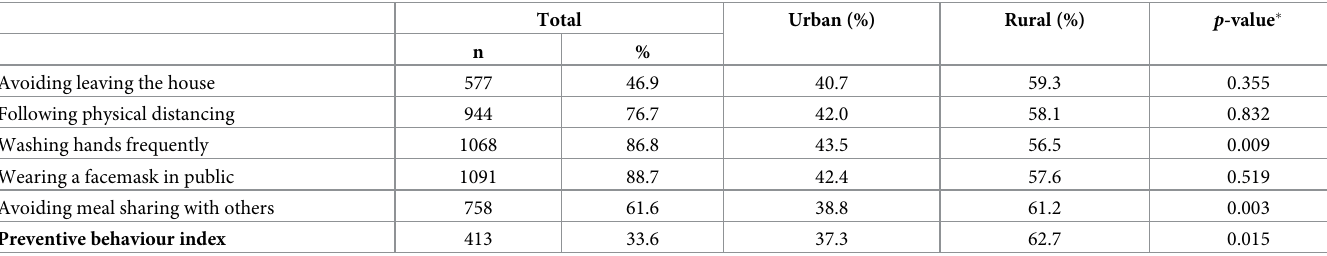
Table 4. Preventive behaviour regarding COVID-19 between urban and rural areas.